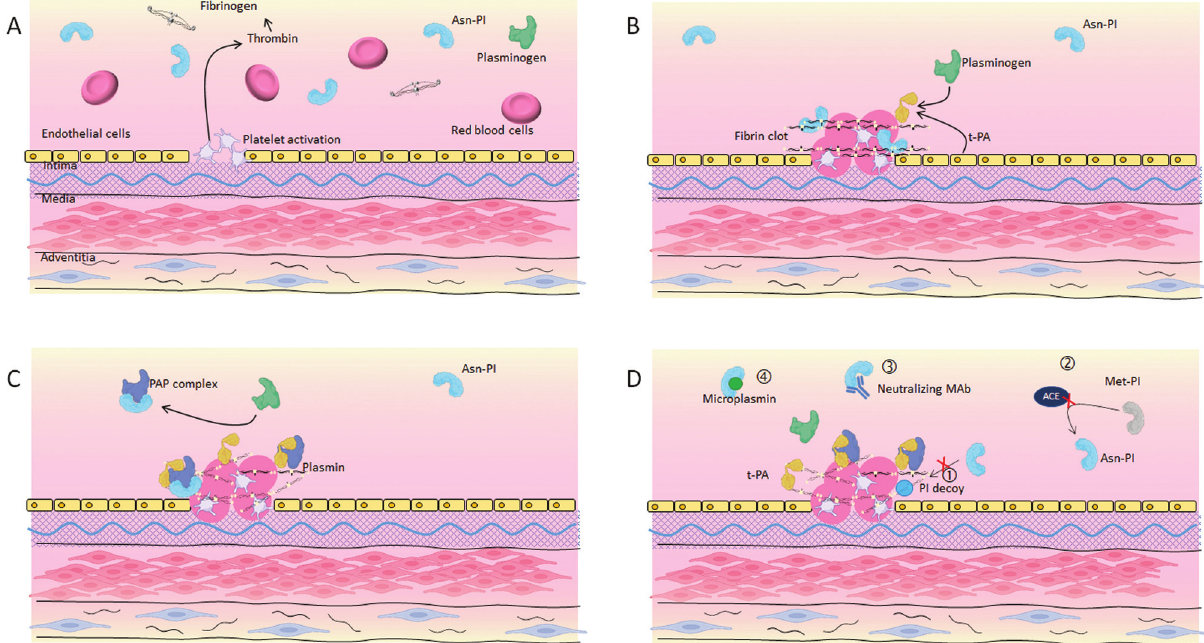
Fig. 4 Critical areas of PI targeted and therapeutic strategies. ( A-C ) PI modulates fi brinolysis in different ways: directly binding to, and rapidly forming a covalent inhibitory complex with plasminogen or plasmin (PAP complex), cross-linking into the fi brin network, mediated by FXIIIa, and inhibiting plasminogen adsorption onto fi brin. As such, attempts to develop any drug inhibiting PI ( D ), tackle one of these areas (1) PI mimicking peptides, (2) inhibitors of ACE, (3) monoclonal antibodies inhibiting PI, and (4) microplasmin. ACE, antiplasmin-cleaving enzyme. TH Open Vol. 6 No. 4/2022 © 2022. The